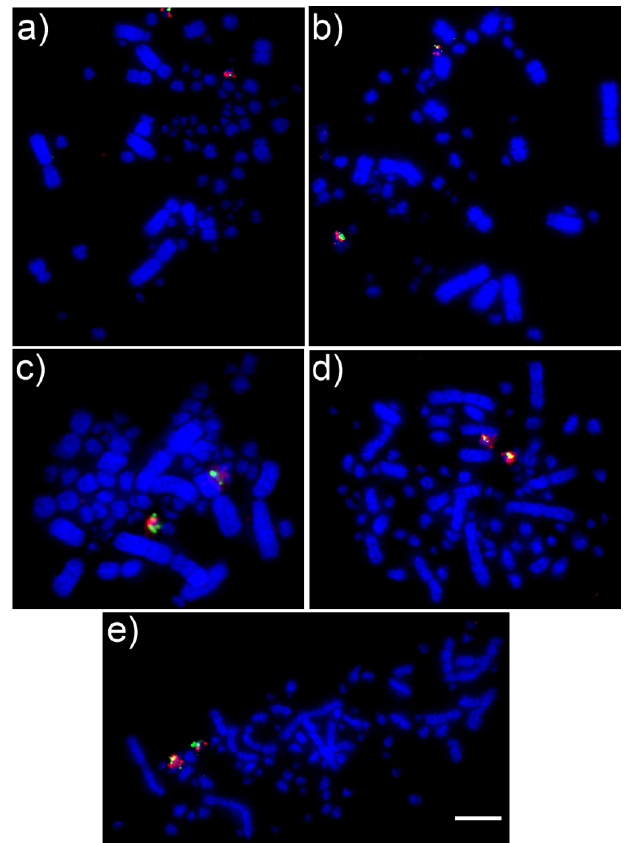
Figure 6. FISH using BACs for chicken chromosome 26 (CH261 ‐ 186M13 FITC and CH261 ‐ 170L23 Texas Red) on chromosomes of different Columbidae species revealing no evidence of interchromosomal rearrangements: ( a ) Columbina talpacoti , ( b ) Patagioenas cayennensi, ( c ) Columbina passerina , ( d ) Geotrygon violacea , ( e ) Geotrygon montana . Scale bar 10 μ m .